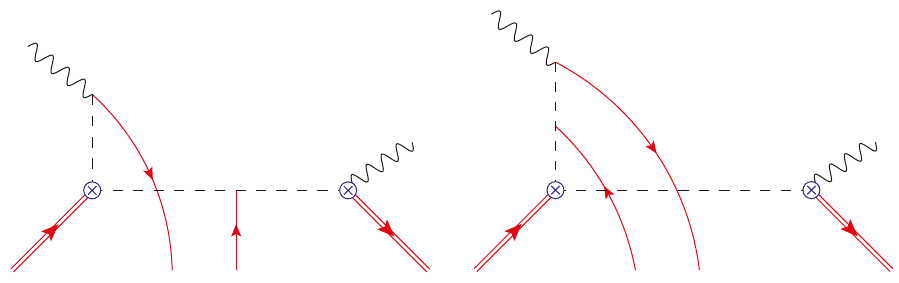
contributions onto HQET. O 7 (cid:13) (cid:0) O 8 g